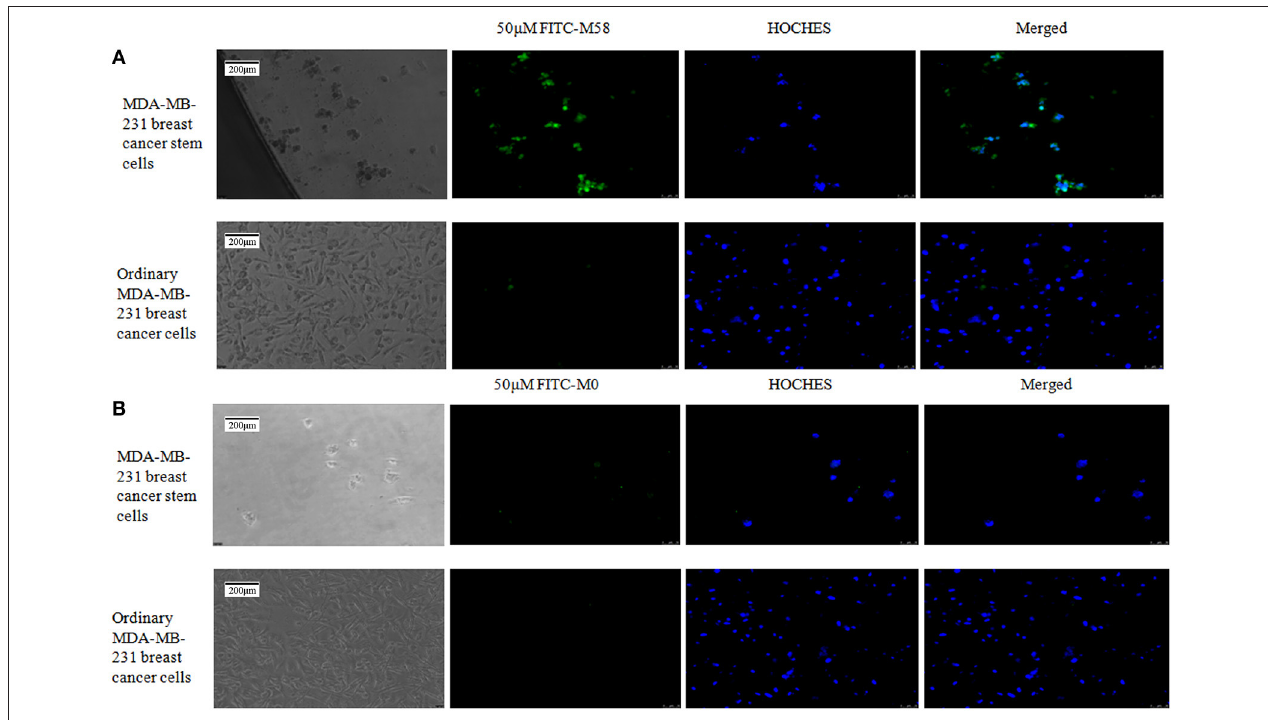
FIGURE 4 | Binding status of polypeptide M58 to MDA-MB-231 breast cancer stem cells and ordinary MDA-MB-231 breast cancer cells. (A) The fluorescein isothiocyanate (FITC)-labeled M58 was incubated with MDA-MB-231 breast cancer stem cells and ordinary MDA-MB-231 breast cancer cells; polypeptide M58 labeled with FITC was observed to specifically bind to MDA-MB-231 breast cancer stem cells, but not to ordinary MDA-MB-231 breast cancer cells. (B) The FITC-labeled control polypeptide M0 was incubated with MDA-MB-231 breast cancer stem cells and ordinary MDA-MB-231 breast cancer cells; the control